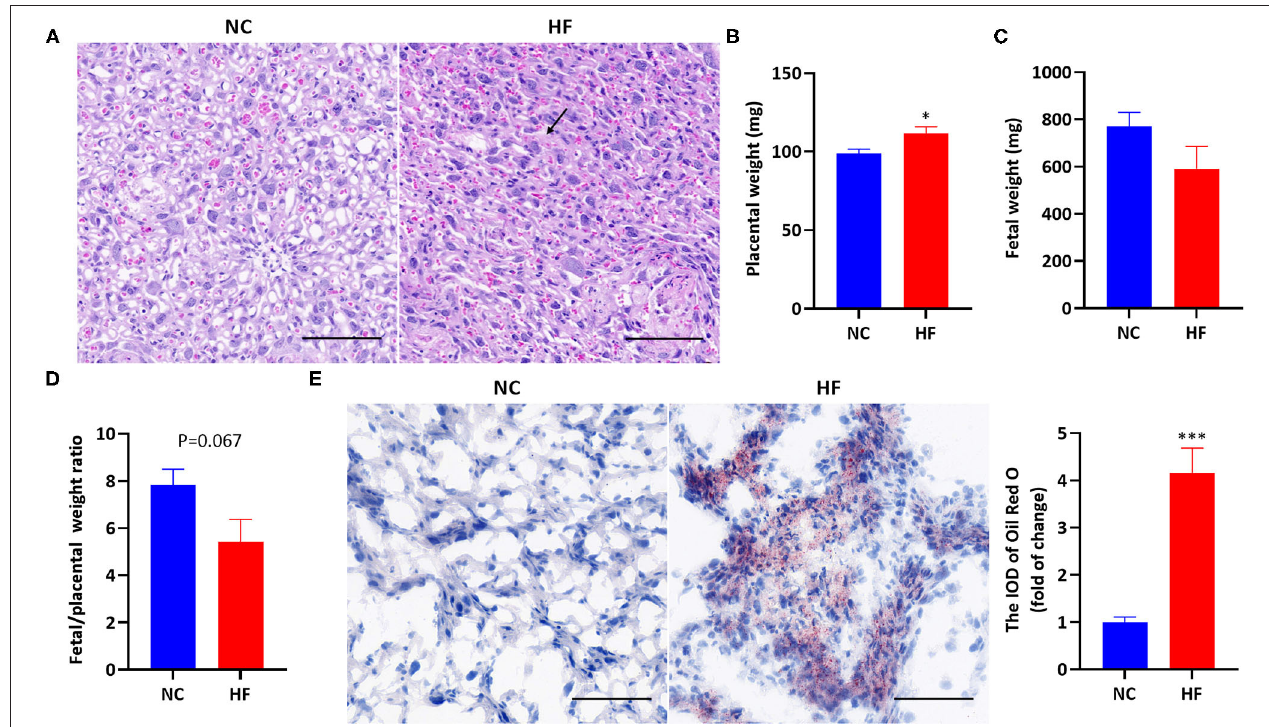
FIGURE 2 | Maternal HF feeding altered the development of the placenta and fetal, and induced lipid deposition in the placenta. (A) Representative images of H&E staining in the placenta. The black arrow indicates interstitial edema, magnification 400x. The scale bar indicates 100 µ m; (B) Placental weight; (C) Fetal weight; (D) Fetal/ placental weight ratio; (E) Representative images and quantitative assessment of Oil Red O staining in the placenta, magnification 400x. The scale bar indicates 100 µ m. Data represented as the mean ± SEM. (NC, n = 6; HF, n = 6–7). * p < 0.05, *** p < 0.001 vs. NC. NC, normal chow diet; HF, high-fat diet; H&E, hematoxylin and eosin; IOD, integrated optical